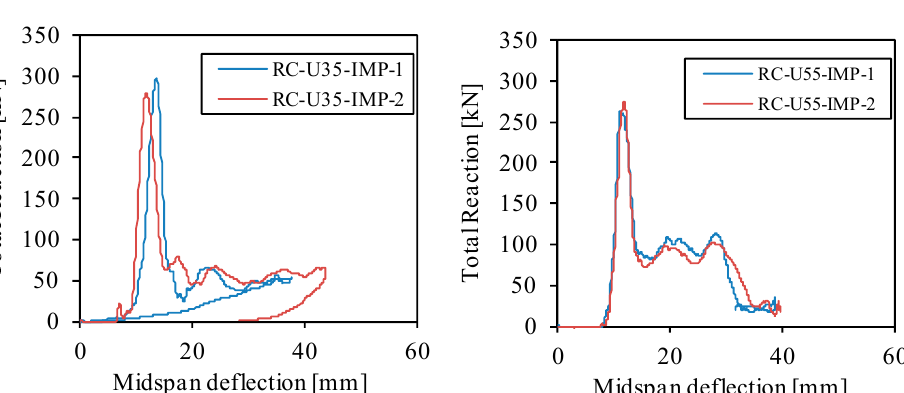
Figure 6. Load-midspan deflection diagrams of tested specimens.